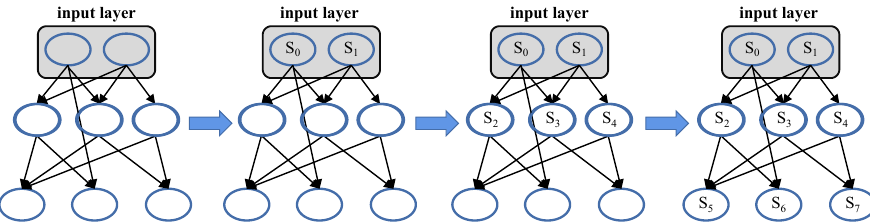
Figure 5. The computing process of the spike firing rates.